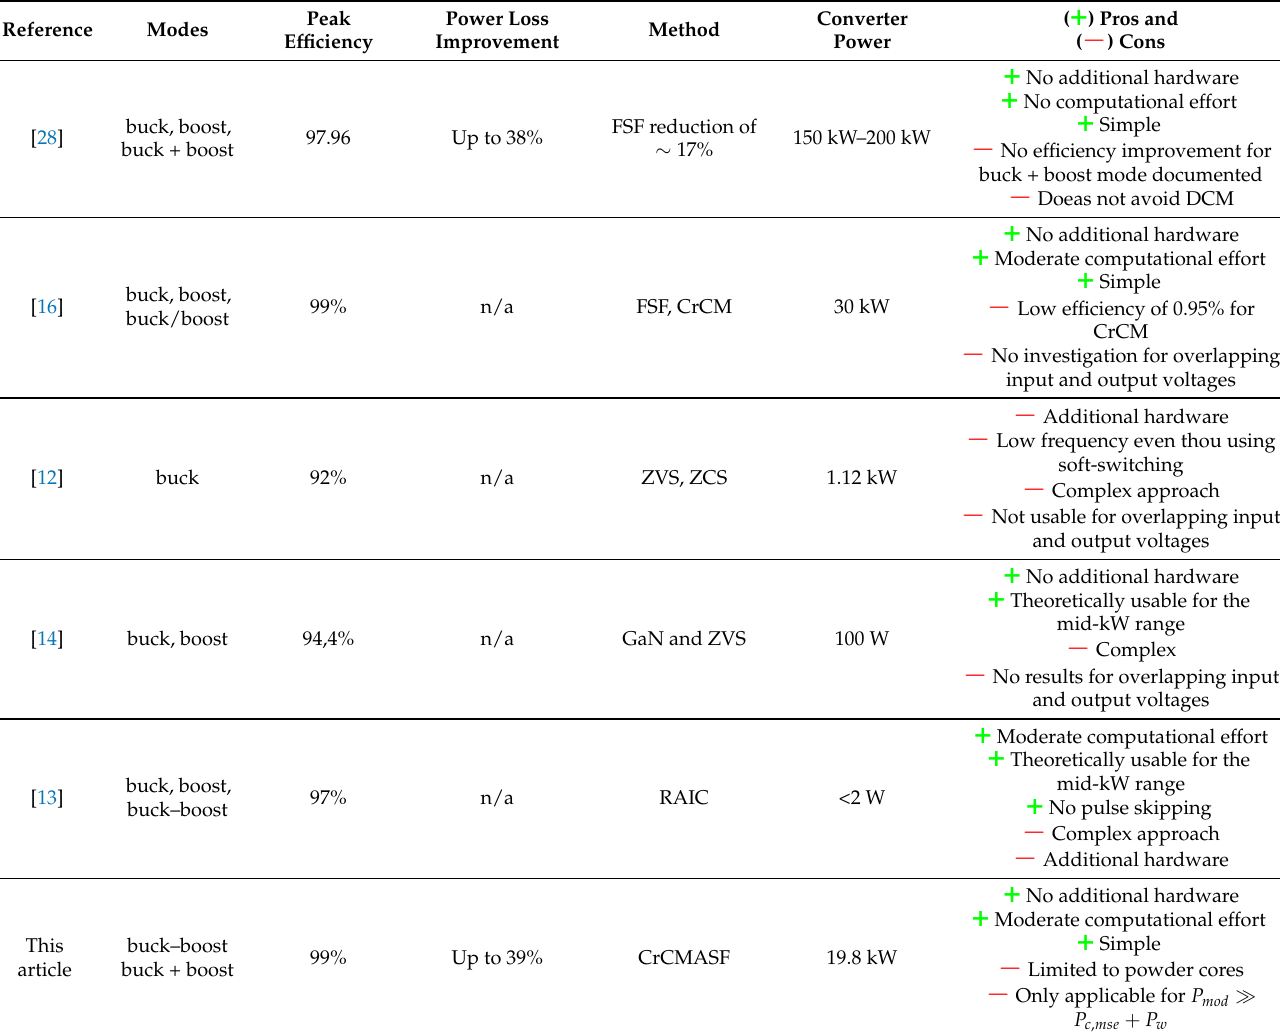
Table 2. Literature review